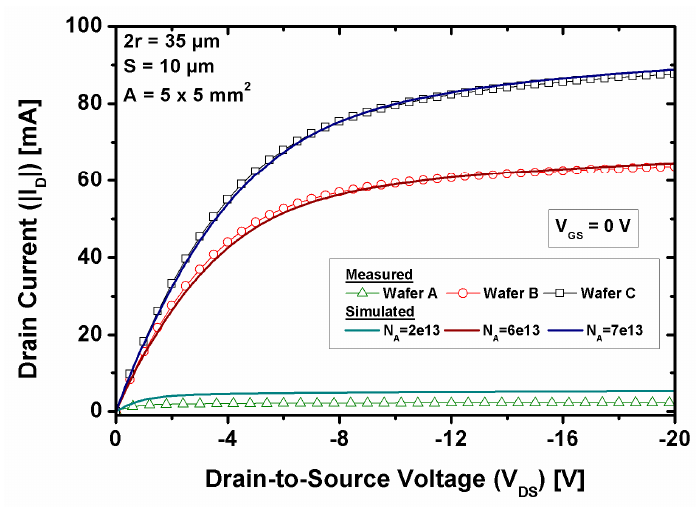
Figure 7. Measured output characteristic curves (| I D | vs. V DS at V GS = 0 V) for several representative V-JFET samples, with 2 r = 35 µm, S = 10 µm and A = 5 × 5 mm 2 , coming from different wafers (A, B, and C), and compared with the corresponding simulated curves for different N A values.